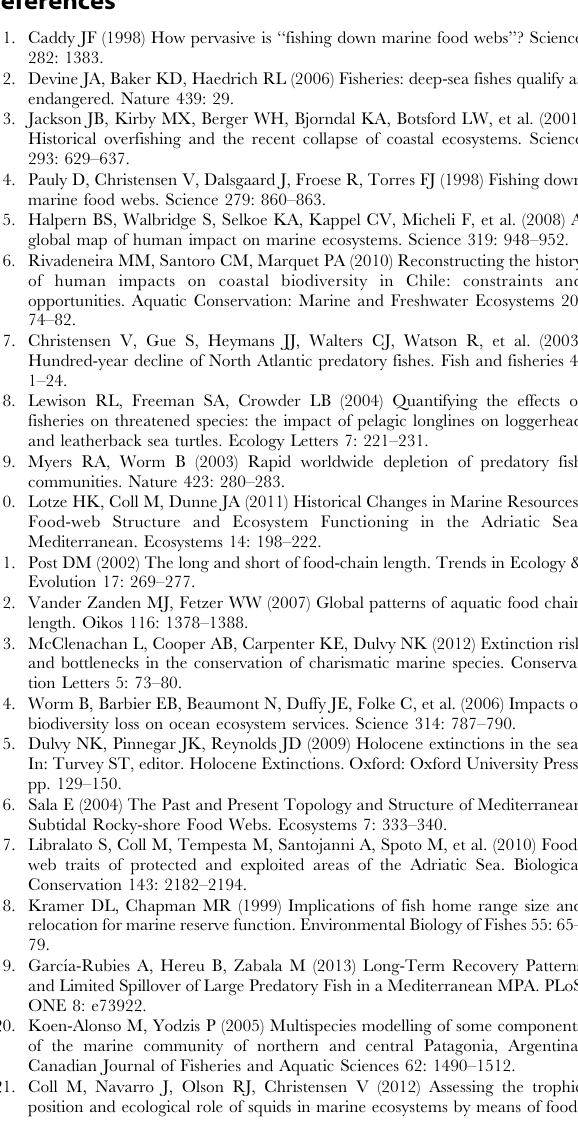
Table S1 Modern nitrogen and carbon stable-isotope ratios in Rı´o de la Plata and adjoining areas. These data have been used to perform the sensitivity test for the method. Table S2 Modern and archaeological nitrogen and carbon stable-isotope ratios in central-northern Patago- nia. Table shows the list of samples, grouped according to their historical period (modern and pre-contact), and d 13 C and d 15 N values. Table S3 Modern and archaeological nitrogen and carbon stable-isotope ratios in southern Patagonia. Table shows the list of samples, grouped according to their historical period (modern, LAP and EAP), and d 13 C and d 15 N